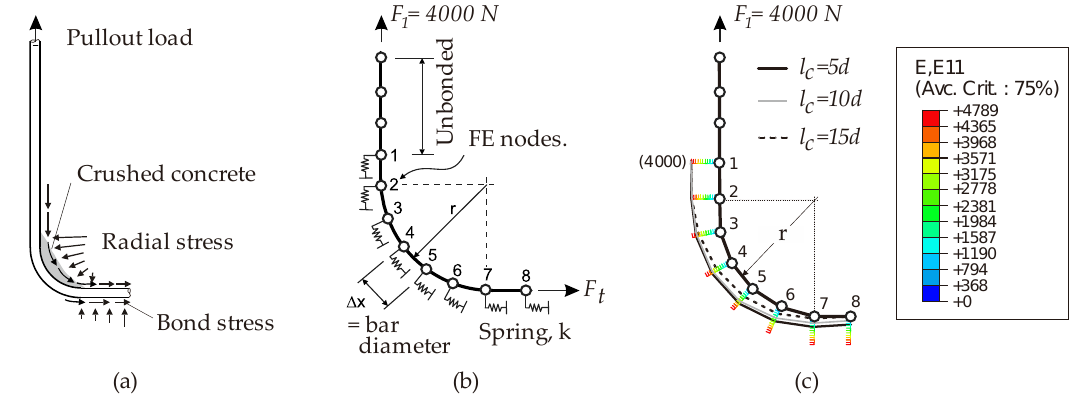
Figure 4 . Physical model vs. mathematical finite element (FE) model for a bent FRP bar; ( a ) pullout test on J-hook FRP bar, ( b ) modelling of bond along FRP/concrete interface, and ( c ) strain distribution along the bent portion of FRP bar.